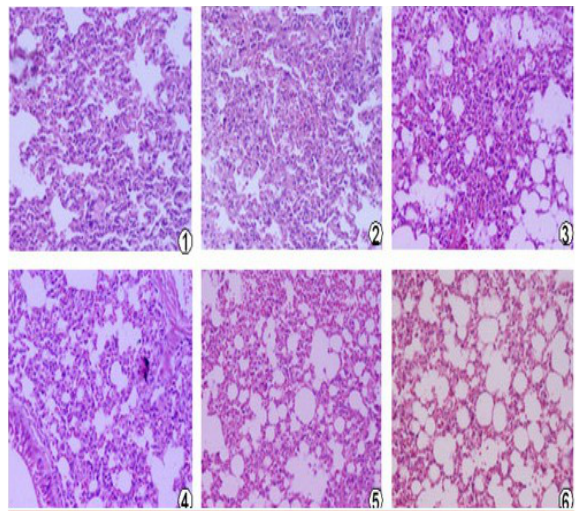
Figure 5. Pathological changes of the mice lung after LAV challenged ( H&E , ×100). Mice were challenged with 10× LD50 A/PR/8/34(H1N1) intranasally, and three days later three mice of each group were sacrificed. Lung tissue was formalin-fixed, embedded in paraffin tissue blocks and sectioned for H and E staining. 1, PBS control group; 2, pcDNA3.1(+) control group; 3, pcDNA3.1(+)/ mBD1 group; 4, pcDNA3.1(+)/ mBD3 group; 5, pcDNA3.1(+)/ mBD1-mBD3 group; 6, normal control